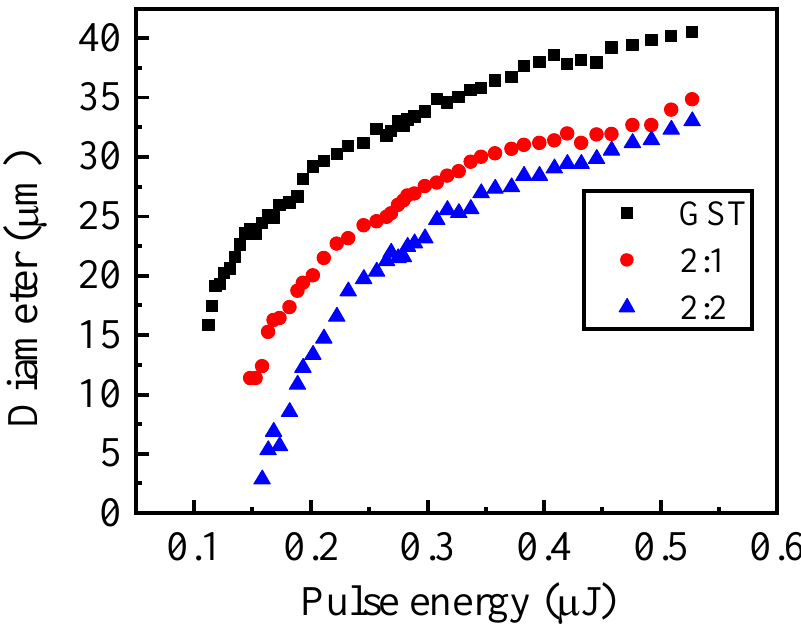
Figure 8. Diameter of different samples ablated by a single laser pulse. The phase transition threshold refers to the minimum laser fluence ϕ th to modify the phase state of the materials, which can be derived as